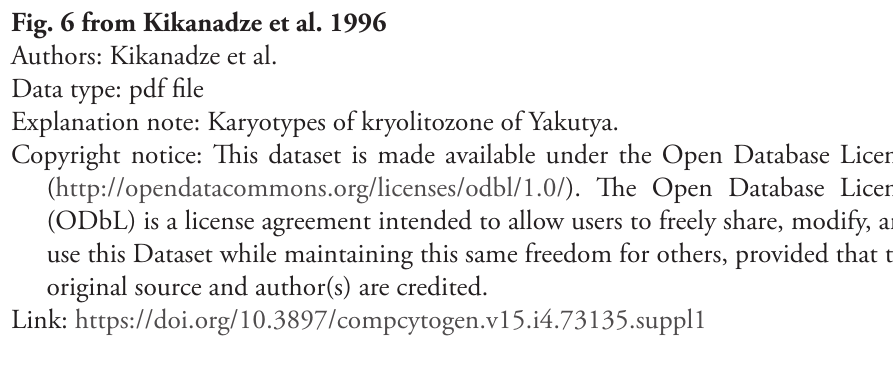
Fig. 6 from Kikanadze et al.